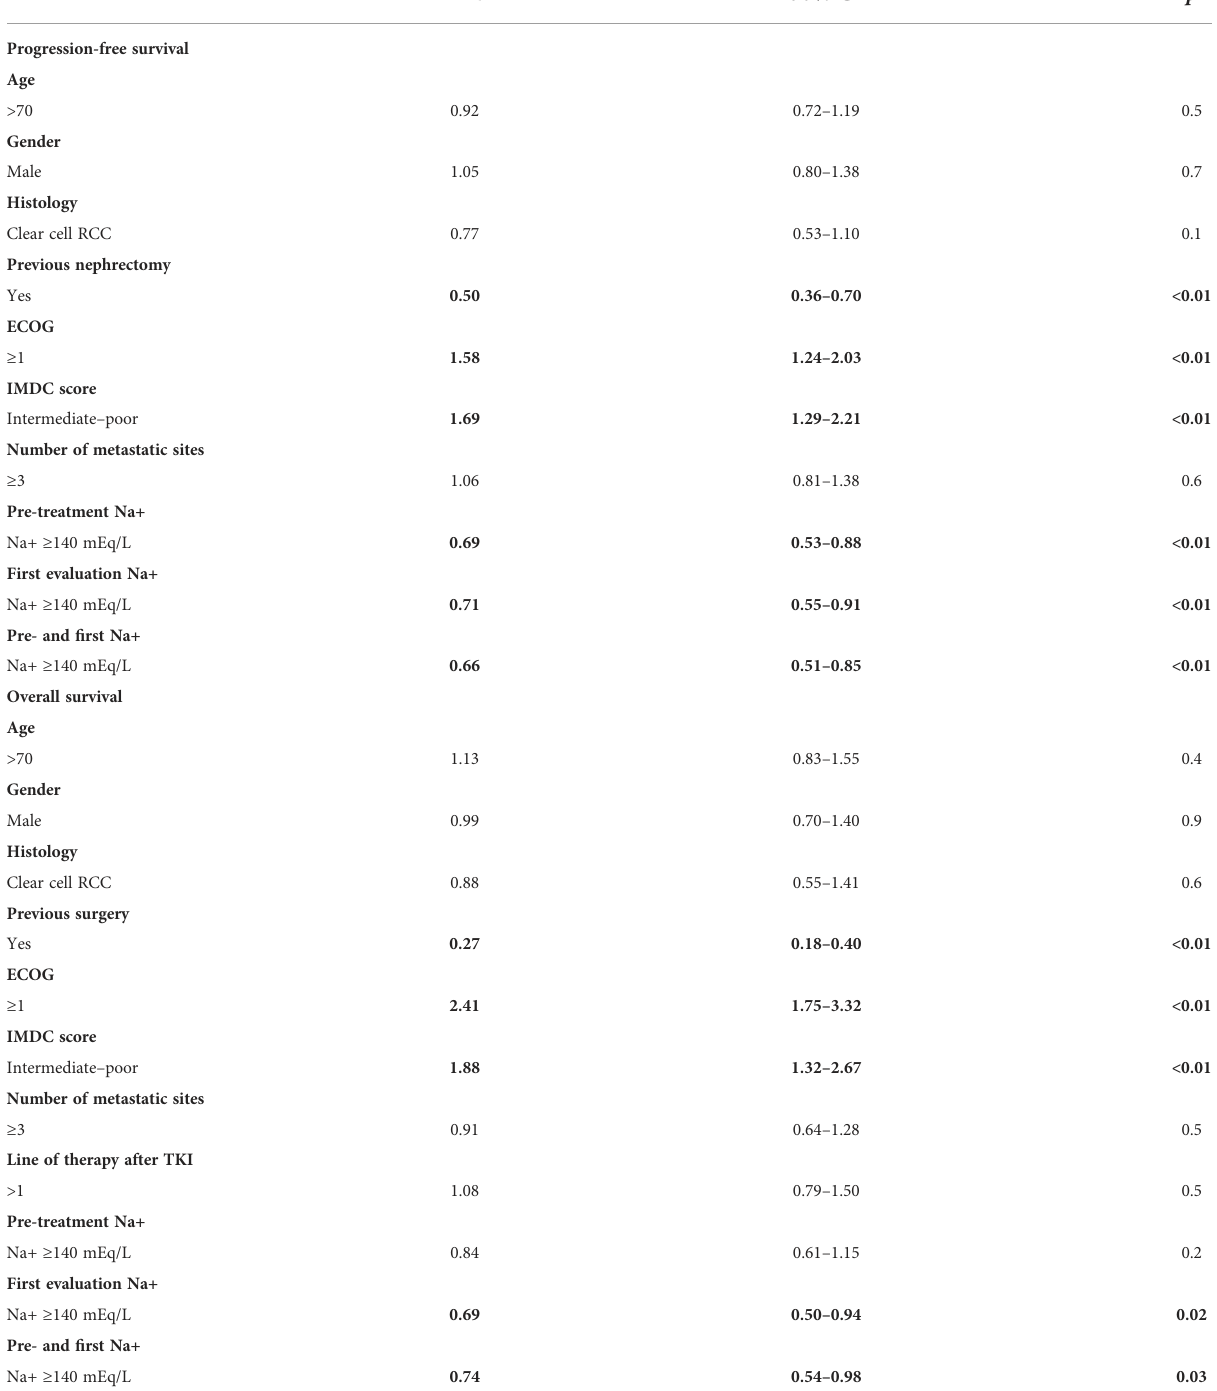
TABLE 3 Univariate analysis for PFS and